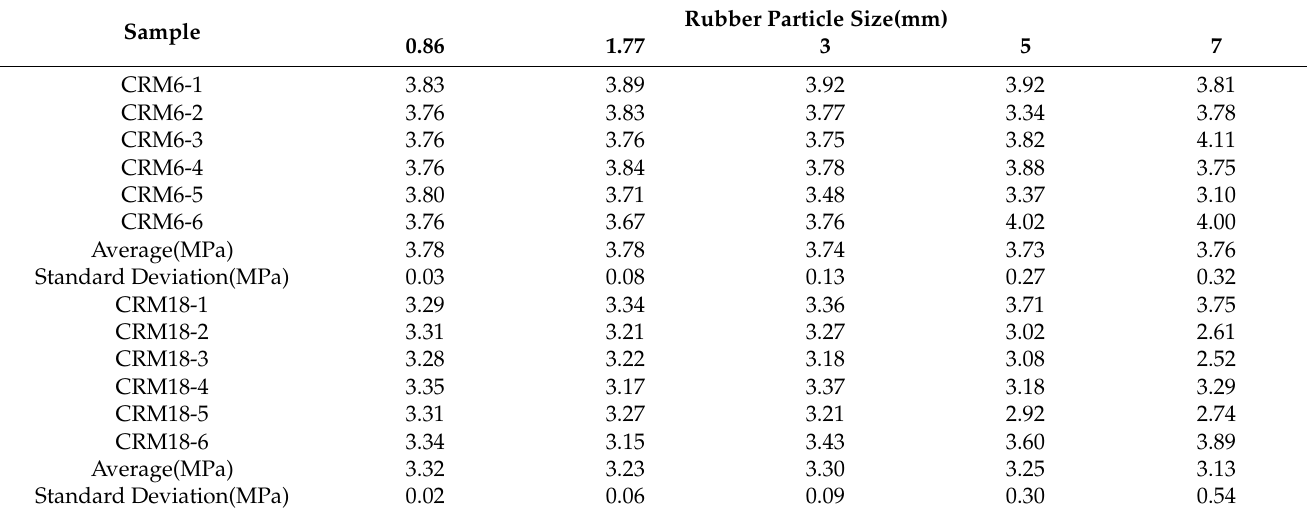
Table 6. The tensile strength of CRM 6 and CRM 18 with six kinds of aggregate